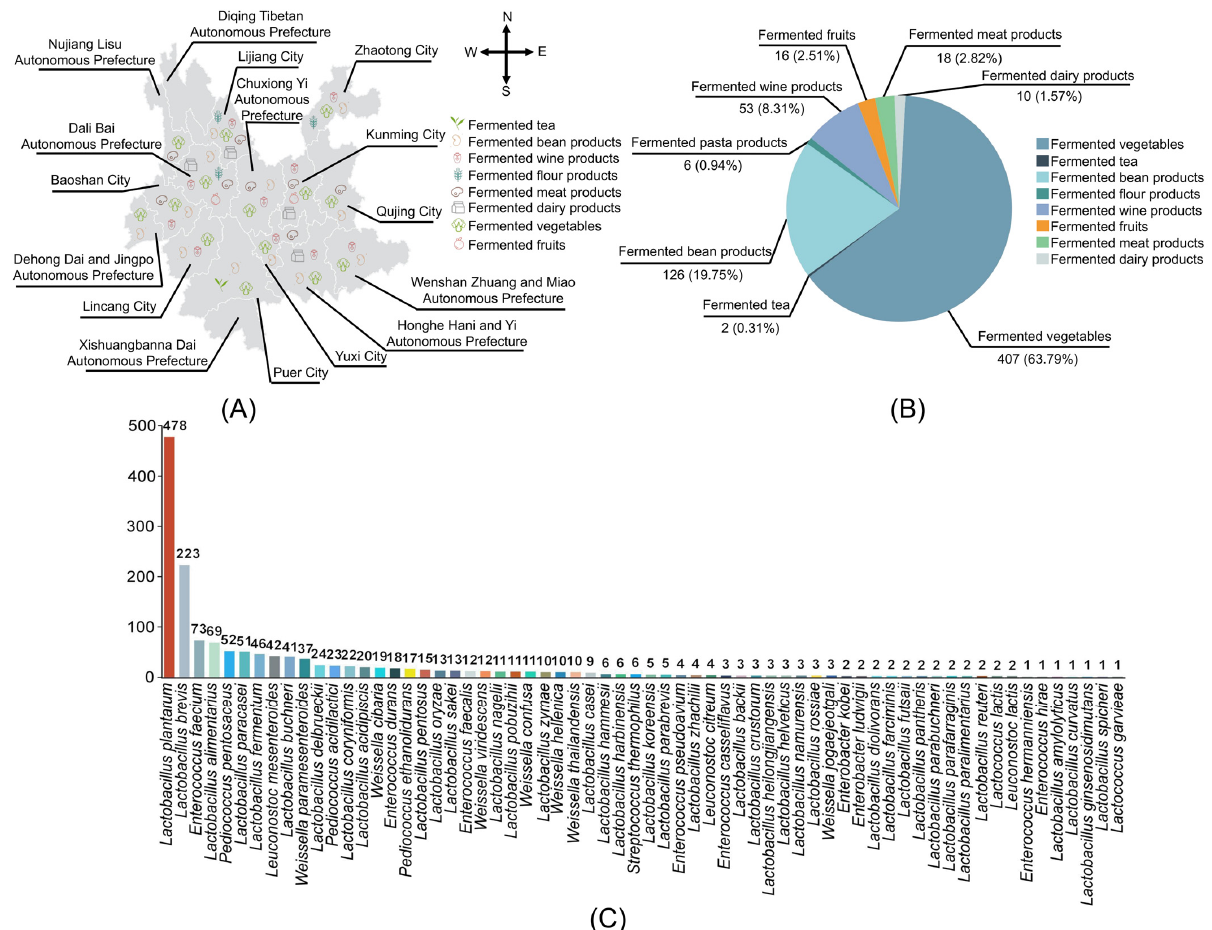
Figure 1. An overview of fermented foods collected from Yunnan Province. ( A ) The distribution of eight types of fermented foods in different regions of Yunnan Province; ( B ) the numbers of each type of fermented food; ( C ) the specific number of LAB.